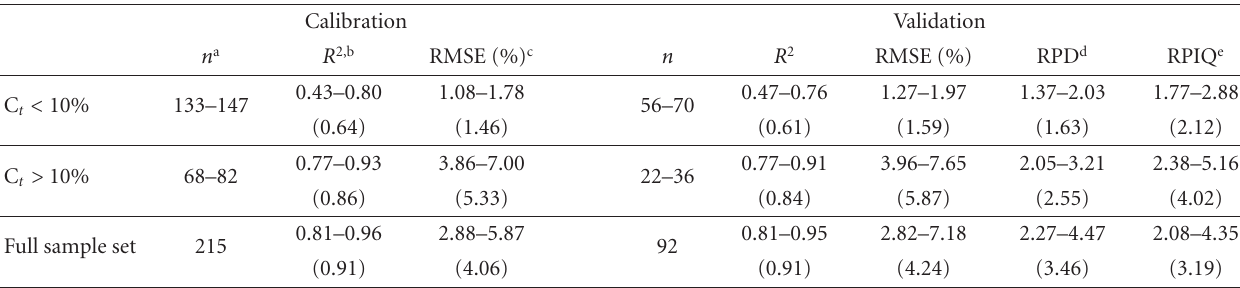
Table 2: Detailed partial least squares regression model results for soil total carbon (C t ) prediction from the subsets of visible/near-infrared di ff use reflectance spectra based on C t content. The range of values reflects the results of 10 random iterations of the models, and the number in parentheses is the mean. Detailed results are also given for full sample set models with no subsetting for comparison.